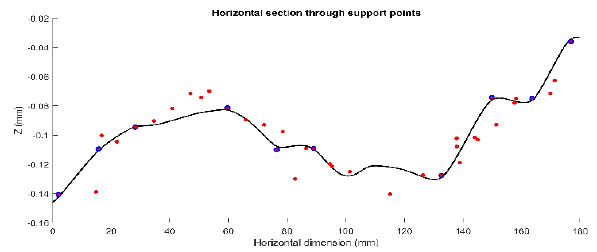
Figure 11 Measured and fitted depth values within a horizontal band across the support surface.